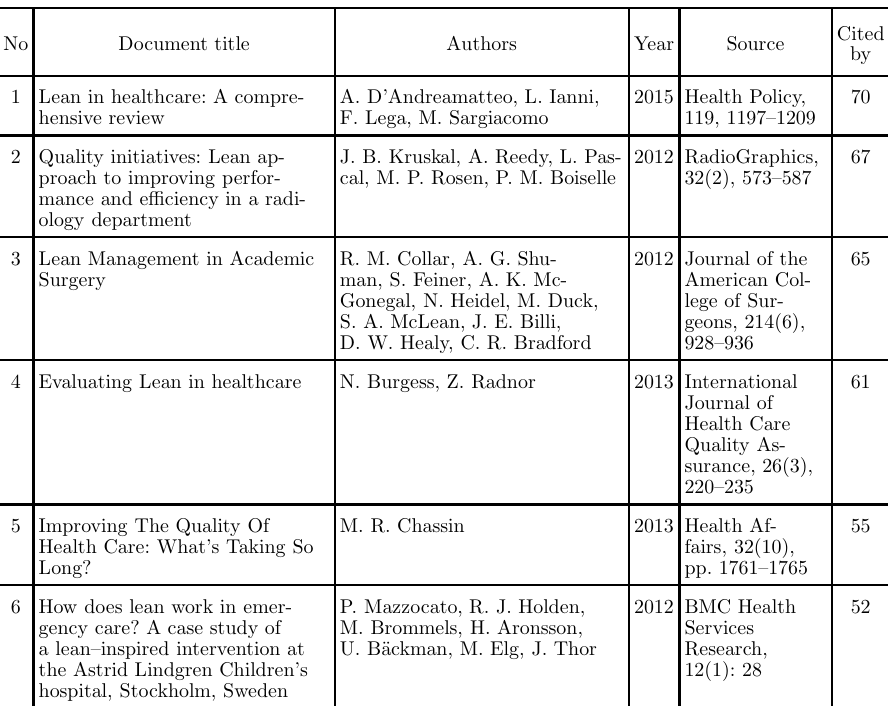
Table 5. List of publications on the quality of cluster 5 medical services in the Scopus database in